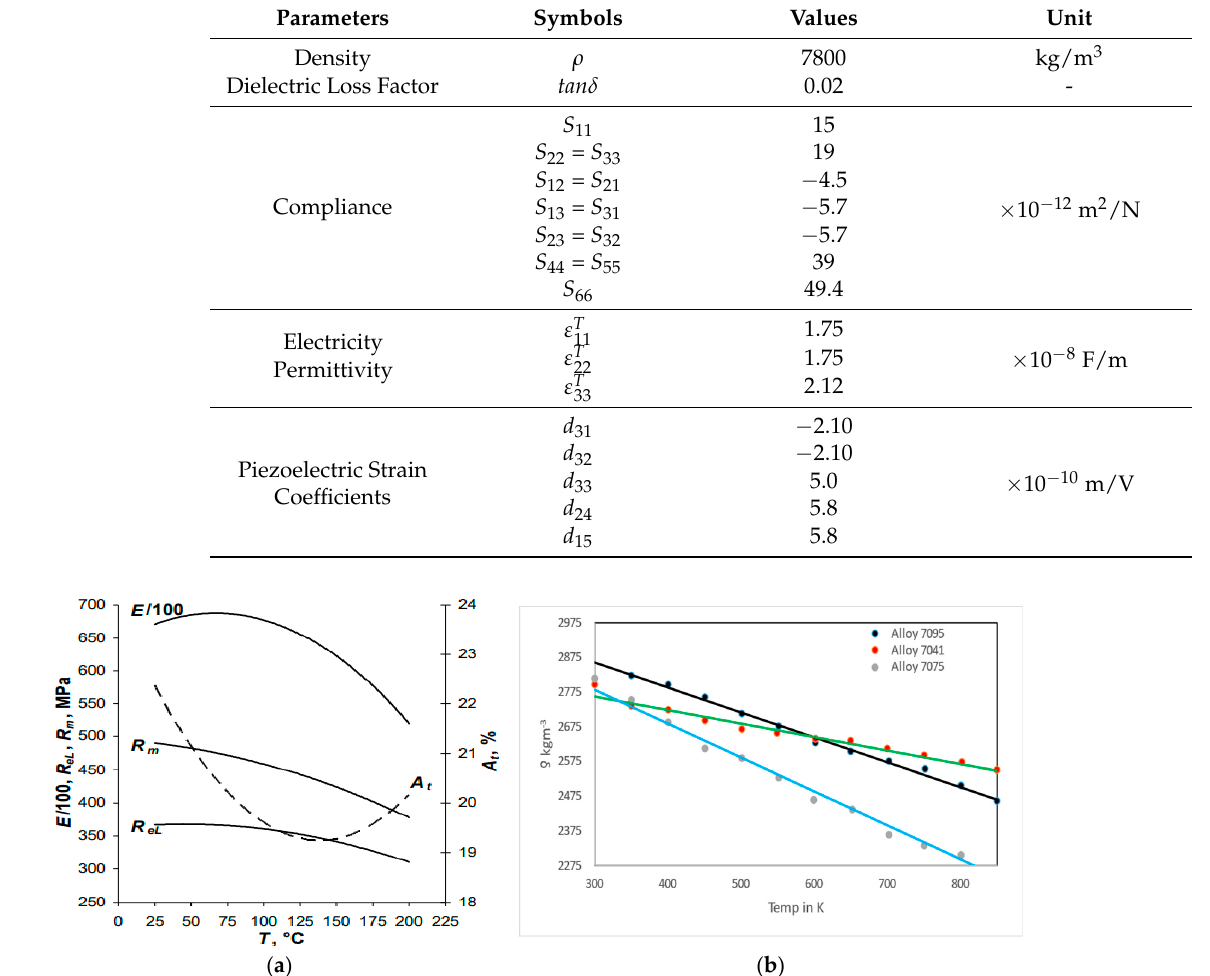
Table 3. Properties of piezoelectric conforming to grade PIC 151 [28].